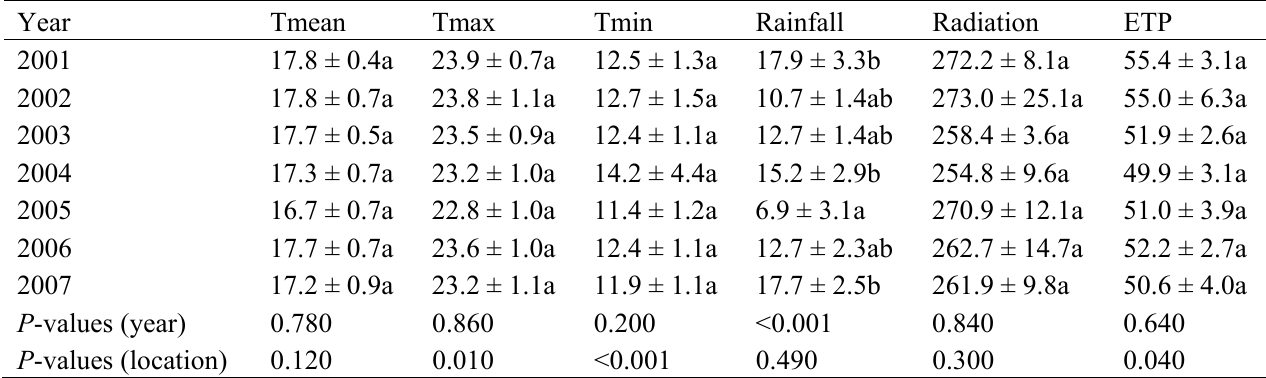
Table 3. Mean (± standard deviation) annual climatic variables for 2001 to 2007. P